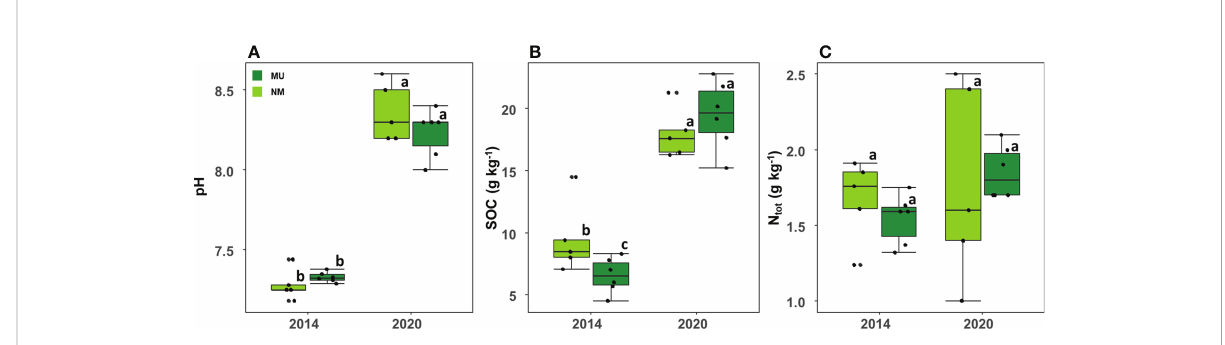
FIGURE 6 Comparison of soil pH (A) , organic carbon (SOC; B ) and total nitrogen content (N tot ; C ) between control (NM; no mulching) and mulching- treated (MU) areas in the 11 soil plots sampled in the years 2014 and 2020. Small letters indicate the results of the Dunn test post-hoc